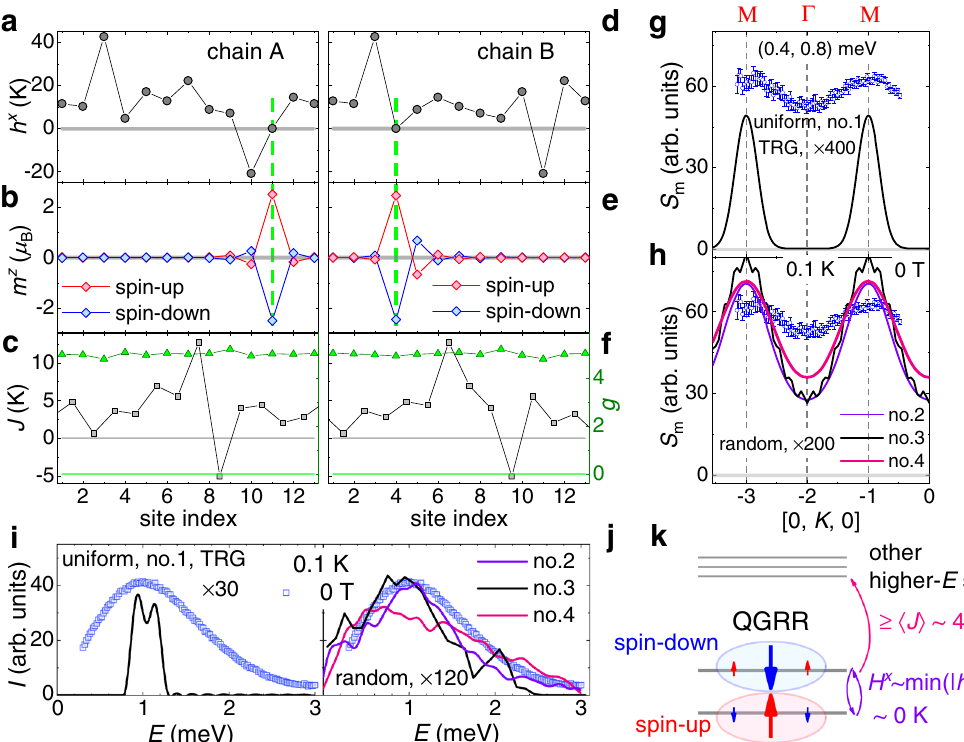
Fig. 4 Calculated ground state and dynamical properties of PrTiNbO 6 . a , c Transverse fi eld distribution, and effective g factors of each Pr 3 + ion, together with the distribution of the Ising couplings, for the sample chain A. b Calculated local magnetic moments and related spin- up and -down states of QGRR in the chain A. d − f Corresponding plots of the sample chain B. g , h Dynamical structure factors are calculated using the uniform chain model no. 1 and the random models no. 2 − 4, respectively. i , j The measured energy dependence of the INS intensities ( E i = 3.7 meV), with the colored lines showing the calculated data of models no. 1 − 4. Error bars on INS data indicate one standard error propagated from neutron counts. A more detailed comparison between experimental and numerical data under applied fi elds can be found in Supplementary Note 2. k Illustration of the energy spectrum where the two-lowest levels represent a